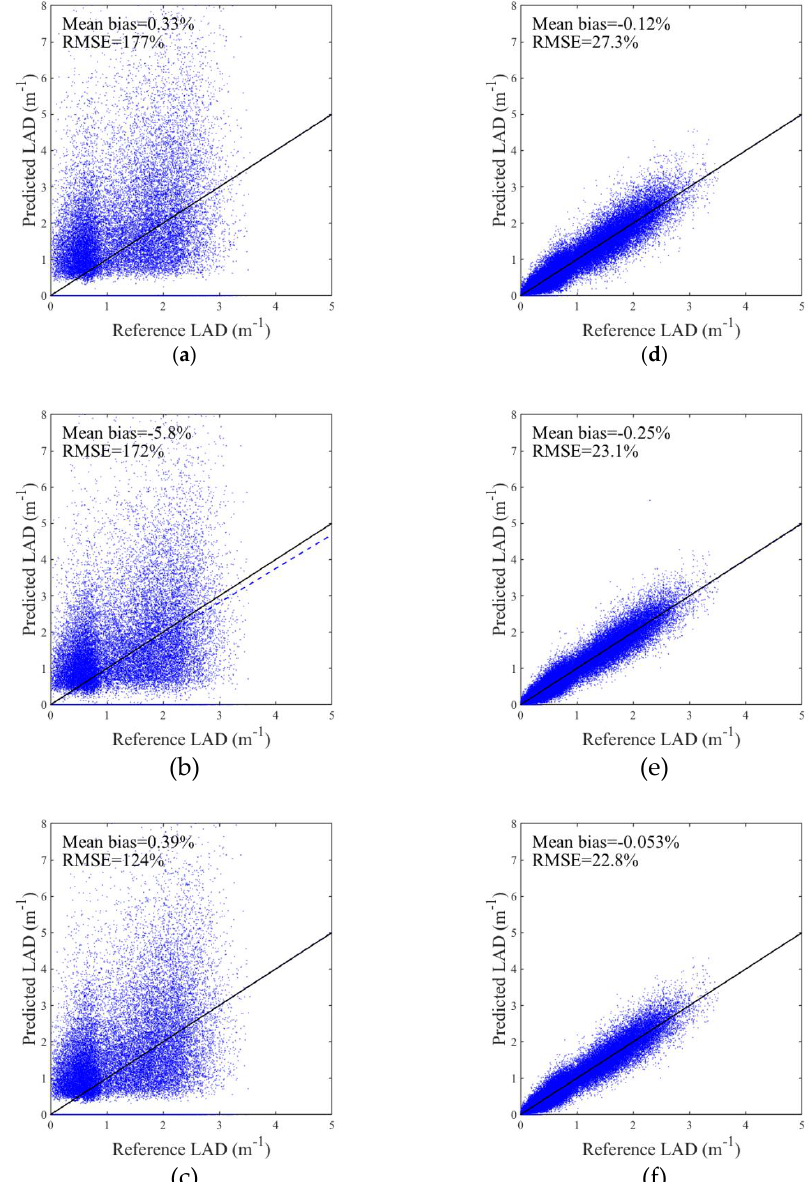
Figure A3. Comparison between predicted and reference LAD, for the three multiview formulations for two classes of beam numbers: ( a ) LAD̃ Nmax , 𝑁 ∈ [5,15[ ; ( b ) LAD̃ NW , 𝑁 ∈ [5,15[ ; ( c ) LAD̃ M , 𝑁 ∈ [5,15[ ; ( d ) LAD̃ Nmax , 𝑁 ∈ [100,500[ ; ( e ) LAD̃ NW , 𝑁 ∈ [100,500[ ; ( f ) LAD̃ M , 𝑁 ∈ [100,500[ .